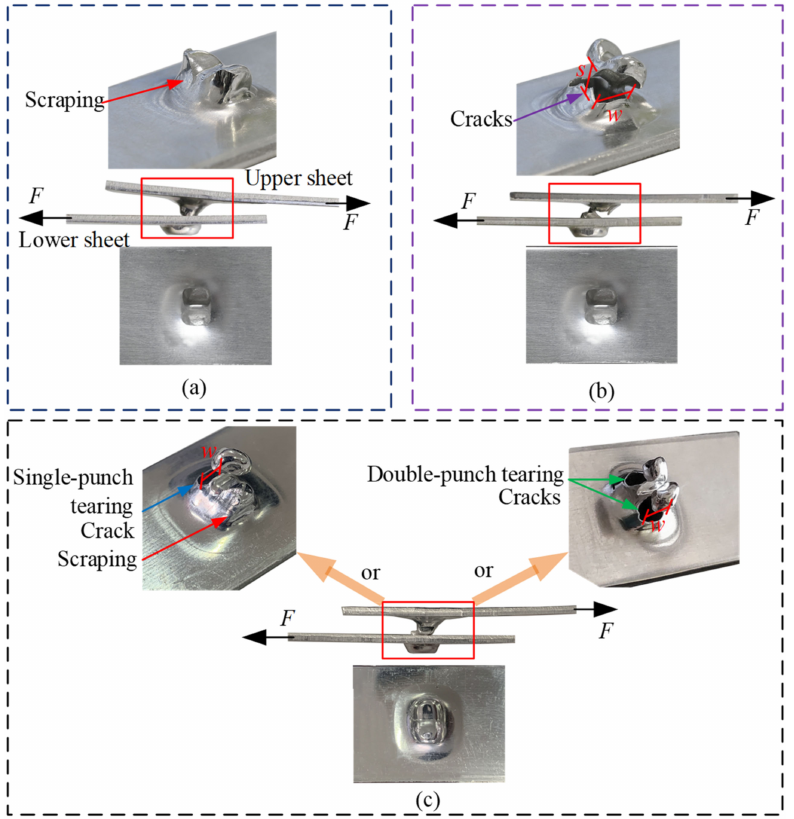
Figure 13. Failure modes of the joint in the shear tests. ( a ) Unbuttoning, ( b ) shearing and ( c ) tearing.